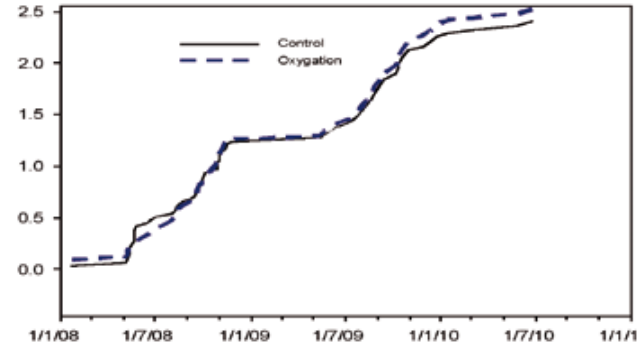
Fig. 3 - Cumulative irrigation input (ML ha -1 ) over the crop period for oxygation and control treatments.